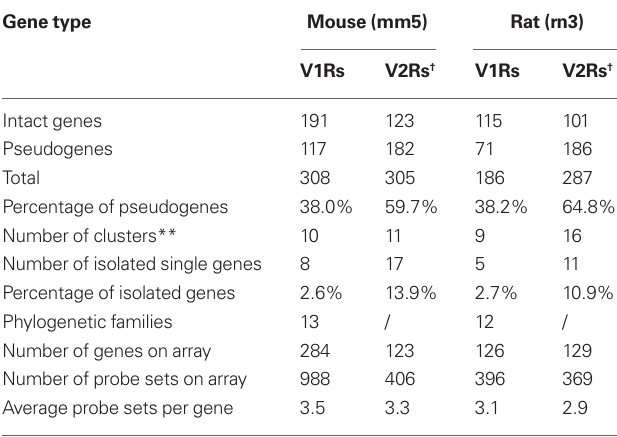
Table 1 | Summary of genomic data mining and probe design for V1R/ V2R